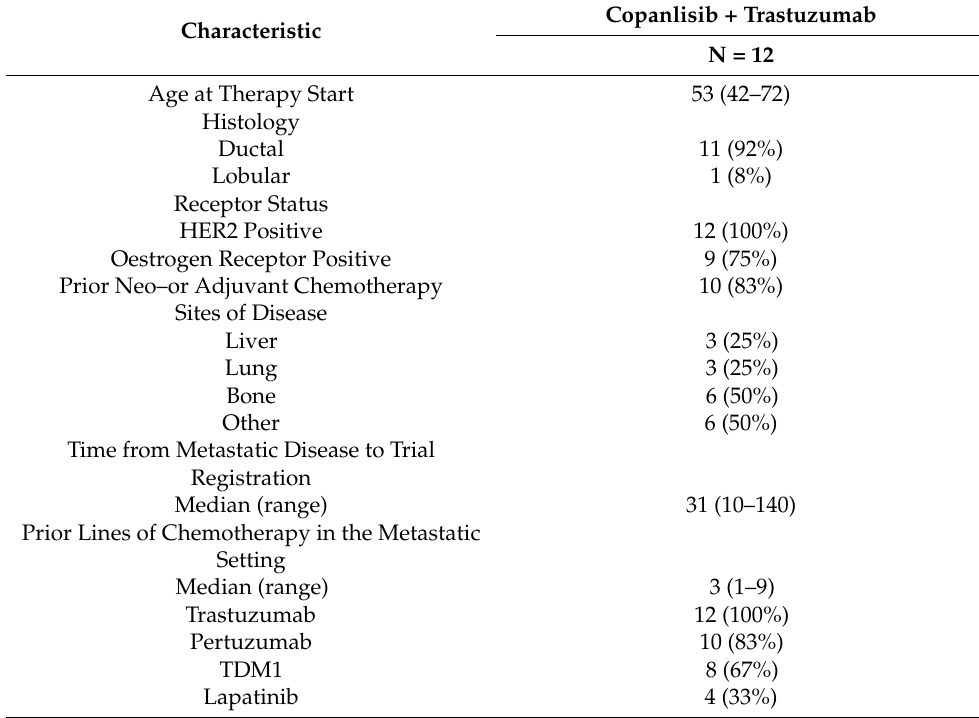
Table 1. Patient characteristics at